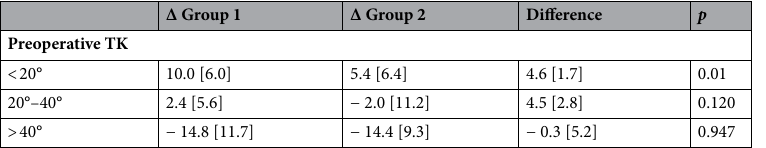
Table 8. Difference between pre and postoperative amount of TK variation within Group 1 and Group 2; mean [standard deviation]; analysis performed using IBM SPSS Statistics 21. TK, thoracic kyphosis.